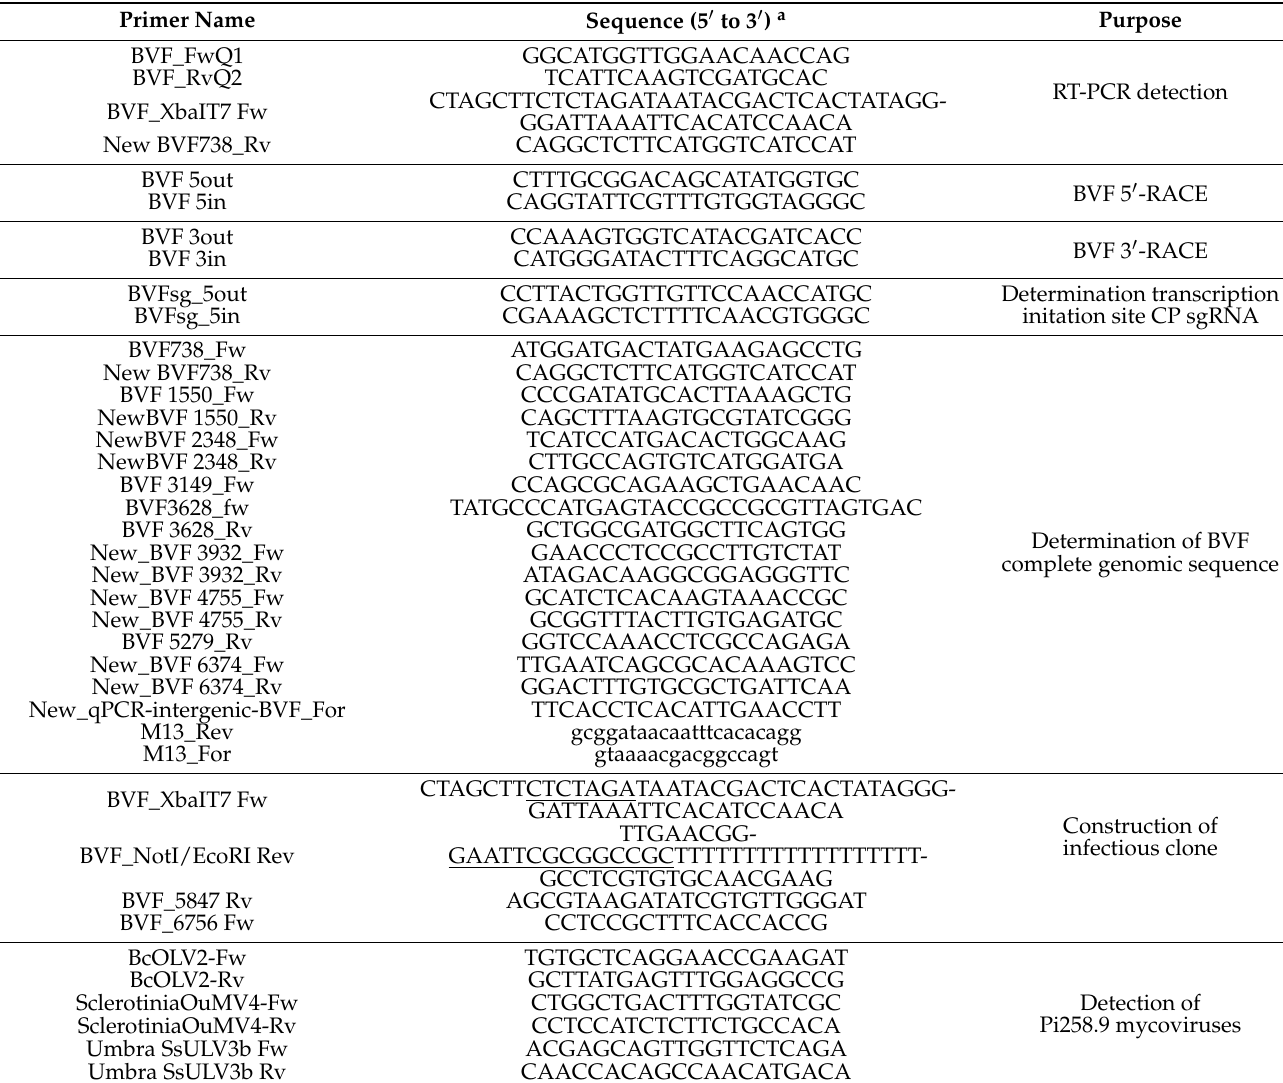
Table 1. List of primers used in the different steps in the